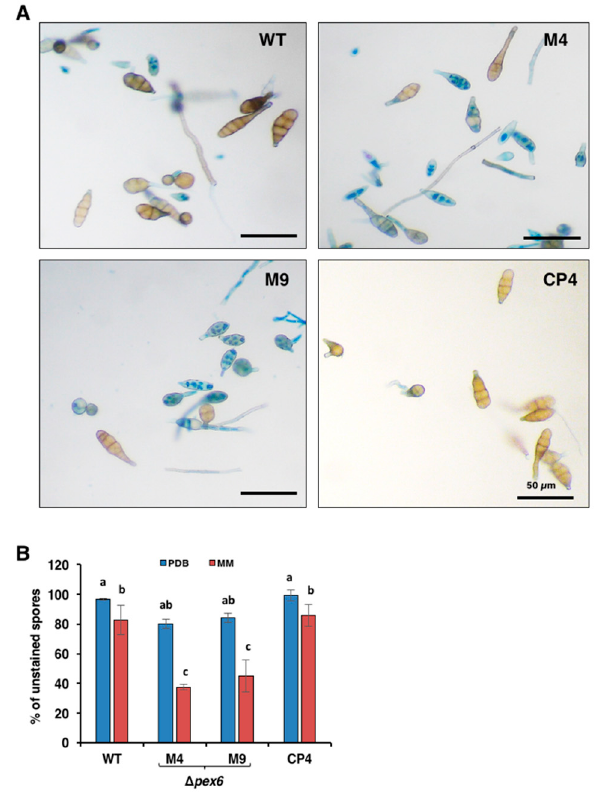
Figure 3. Pex6 is required for cell viability in A. alternata . ( A ) Assays for the viability of conidia prepared from wild type (WT), two pex6 mutants ( ∆ pex6 -M4 and M9) and the complementation strain (CP4) by Evan’s blue staining. Live cells are capable of expelling dye and remain clear, whereas dead cells fail to expel dye and are stained blue; ( B ) Percentage of unstained conidia collected from fungal strains were incubated in potato dextrose broth (PDB) or minimal medium (MM) for 7 h. Significance of di ff erence between means was analyzed using Tukey’s HSD post-hoc test ( p ≤ 0.05). Means ( n = 100) followed by the same letters are not significantly different.